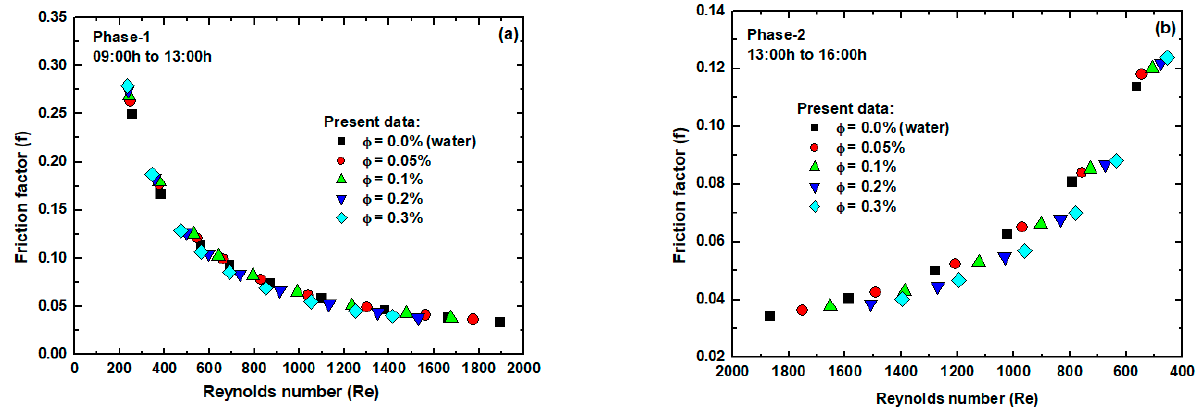
Figure 15. The hybrid nanofluids experimental friction factor; Phase-1 ( a ), and Phase-2 ( b ). Figure 15b represents the friction factor of hybrid nanofluids at different Re in